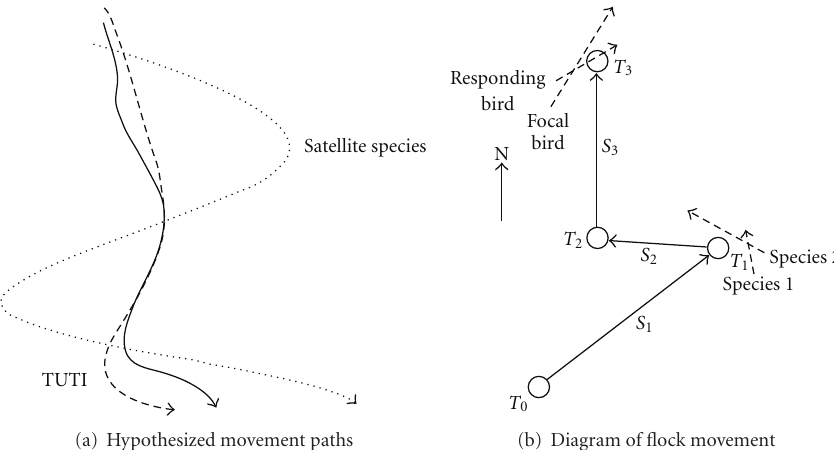
Figure 1: (a) Illustration of one example of the hypothesized relationships between the overall flock movement path (using successive flock centers to chart the path; black line) and the movement paths of two individual flock participants: TUTI (nuclear species; dashed line) and a satellite species (dotted line). (b) Diagram of a 15-minute portion of a flock movement path with T 0 , T 1 , T 2 , and T 3 representing estimated flock centers at 0, 5, 10, and 15 minutes respectively. Lines S 1 , S 2 , and S 3 represent “movement” segments between estimated flock centers, with the length of the line representing the movement distance of the flock and the arrow showing the overall flock movement direction (azimuth) between flock centers. Dashed lines (SPECIES 1 and SPECIES 2) represent the observed movements of 2 randomly selected birds observed while at flock center T1 (to be correlated with flock path). Dashed lines at T3 represent the movements of a FOCAL BIRD and a RESPONDING BIRD (an individual in the same general area that moves immediately after the focal individual moves) to be correlated with each other for within-flock analysis. These observations were made at all flock